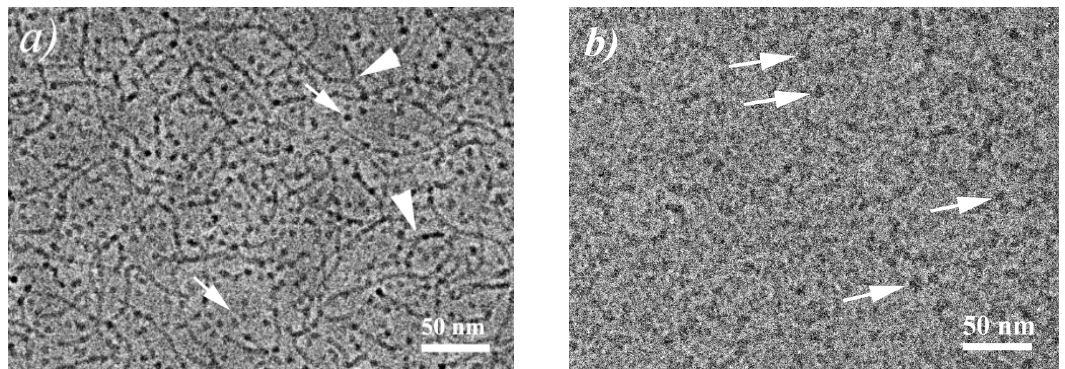
Figure 4. Cryo-TEM micrographs for aqueous solutions containing 117 mM C8TAB and 78 mM potassium oleate and 70 ( a ) or 90 ( b ) mM n-decane at 20 °C. Branching points of cylindrical micelles are indicated by arrowheads, microemulsion droplets—by arrows.